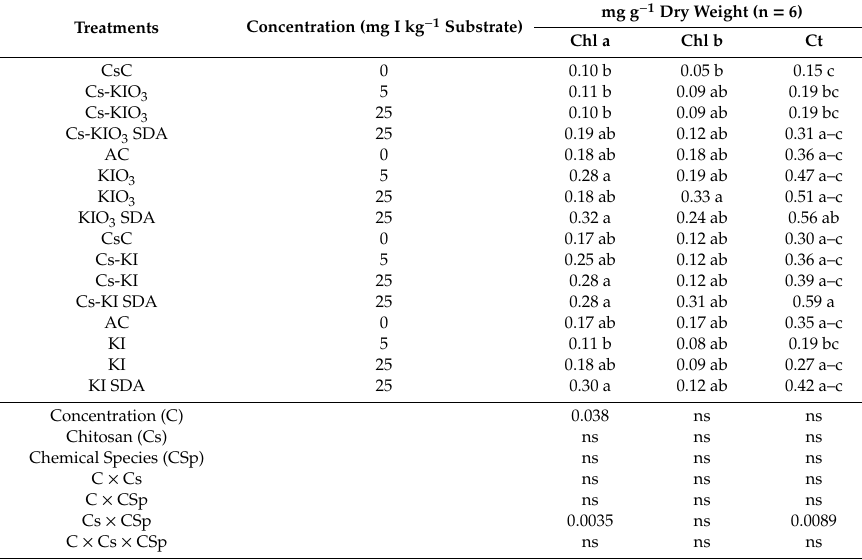
Table 5. Content of chlorophyll a, chlorophyll b, and total